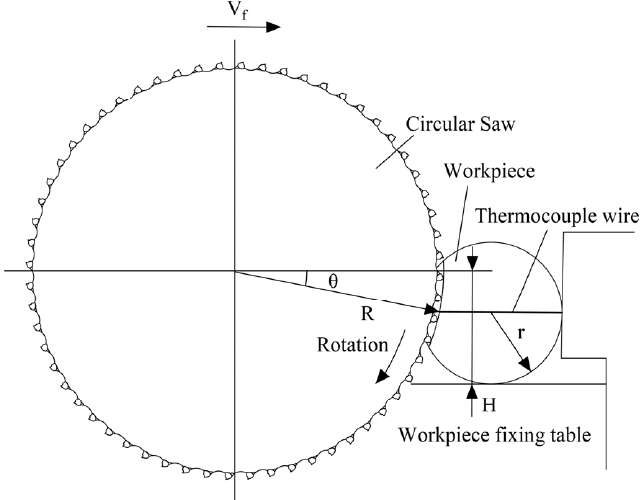
Figure 4. Position relationship of workpiece, saw blade, and thermocouple wire.